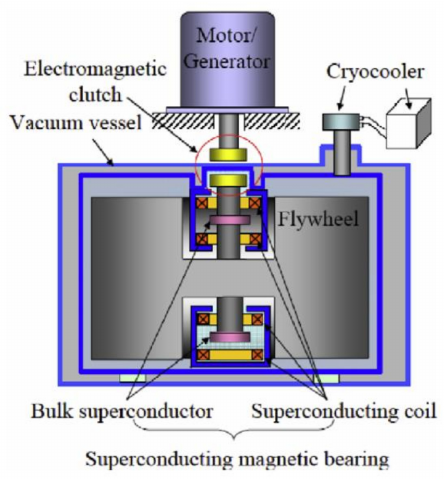
Figure 12. Superconducting magnetic bearing, adapted from